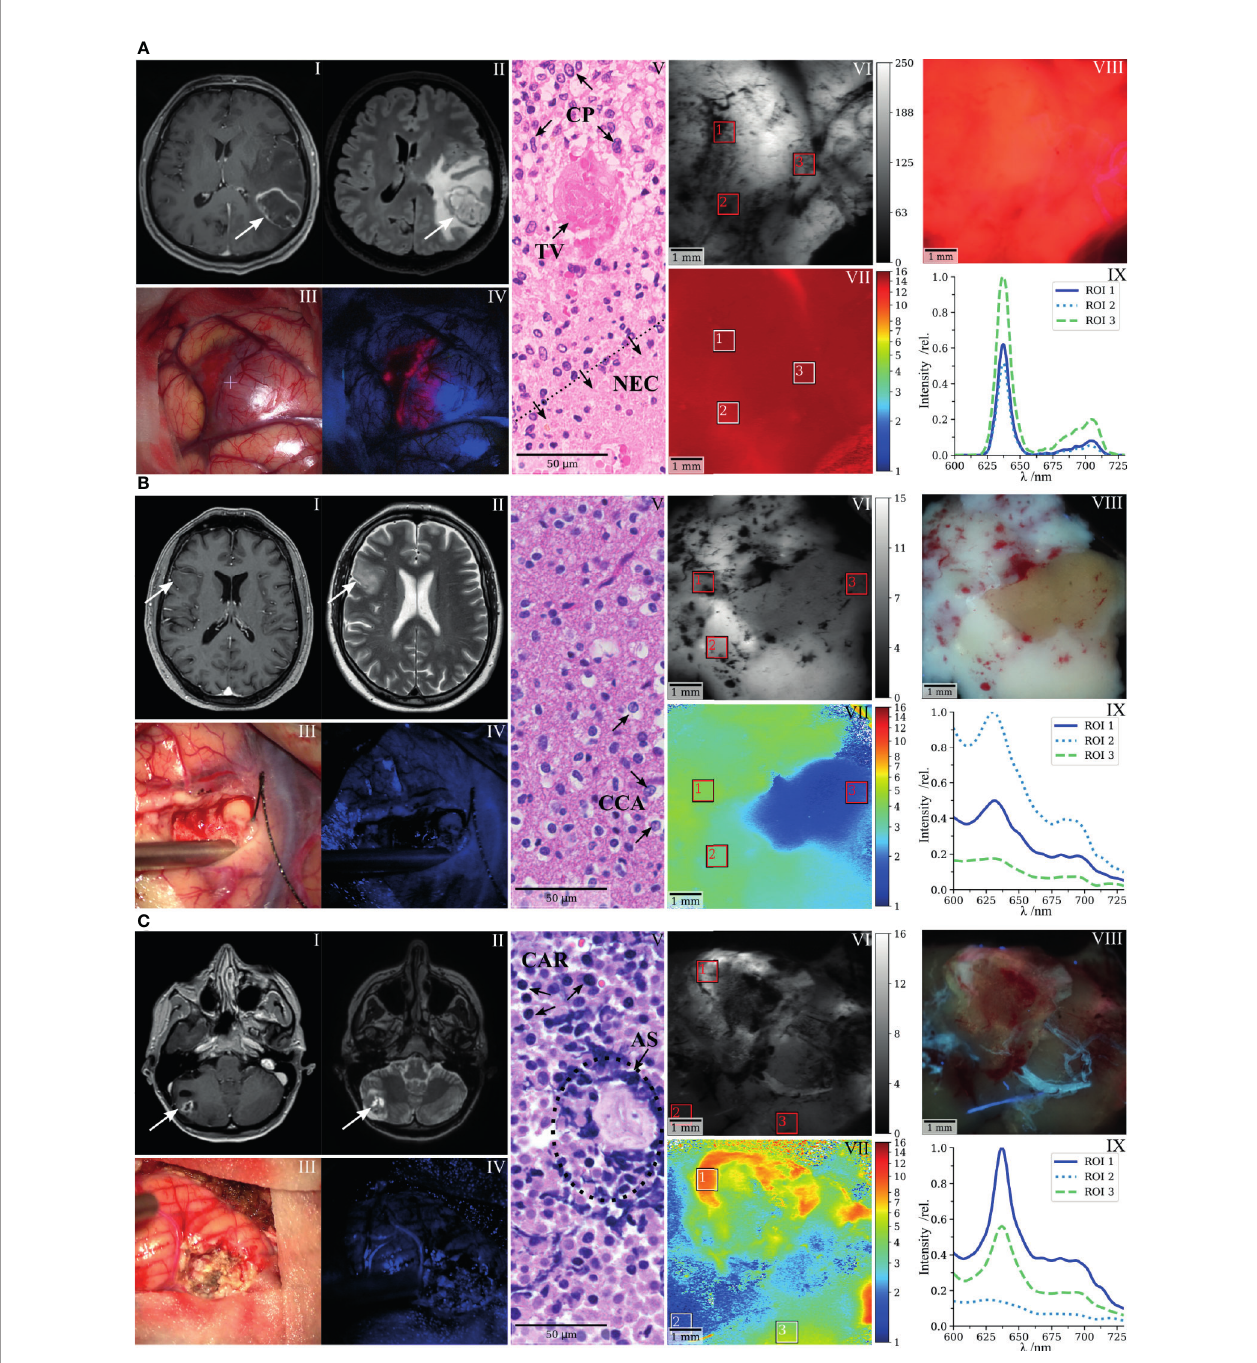
FIGURE 3 | FD-FLIM delineation of PpIX and spectroscopic co-validation illustrated with three selected clinical cases. (A) Glioblastoma, (B) low-grade glioma, and (C) bronchial carcinoma metastasized to the cerebellum. (I,II) Preoperative T1- and T2-weighted MRI, (III,IV) surgical microscope white light and BLUE 400 fl uorescence images taken during cytoreductive surgery, (V) representative histopathological section stained with hematoxylin and eosin, (VI,VII) demodulated fl uorescence lifetime (in ns) acquired on resected specimens with the raster-scanning FD-FLIM system, (VIII) fl uorescence image fl uorescence intensity (in mV RMS ) and of the respective specimens acquired with a scienti fi c camera, and (IX) spectra acquired on the indicated ROIs in VI and VII; the fl uorescence intensity (relative units) is plotted as a function of wavelength (in nm); CP, cellular pleomorphism; TV, thrombosed vessel; NEC, necrosis; CCA, clear-celled appearance; CAR, carcinoma cells; AS, arti fi cially squeezed